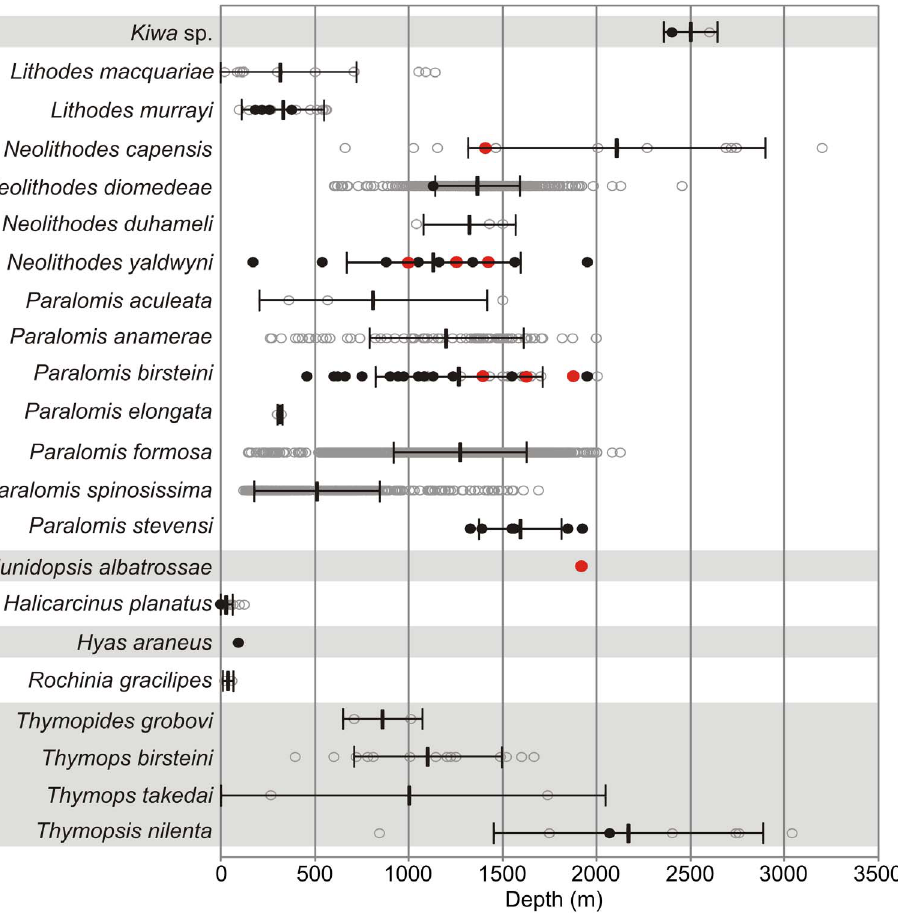
Figure 7. Depth ranges of Southern Ocean crabs and lobsters. Thick black vertical bars=mean depth of records, horizontal bars indicate standard deviation from that mean. Grey circles=all records from the Southern Ocean and neighbouring regions, black dots=records from south of 60 u S, red dots=records from the Antarctic shelf/slope.